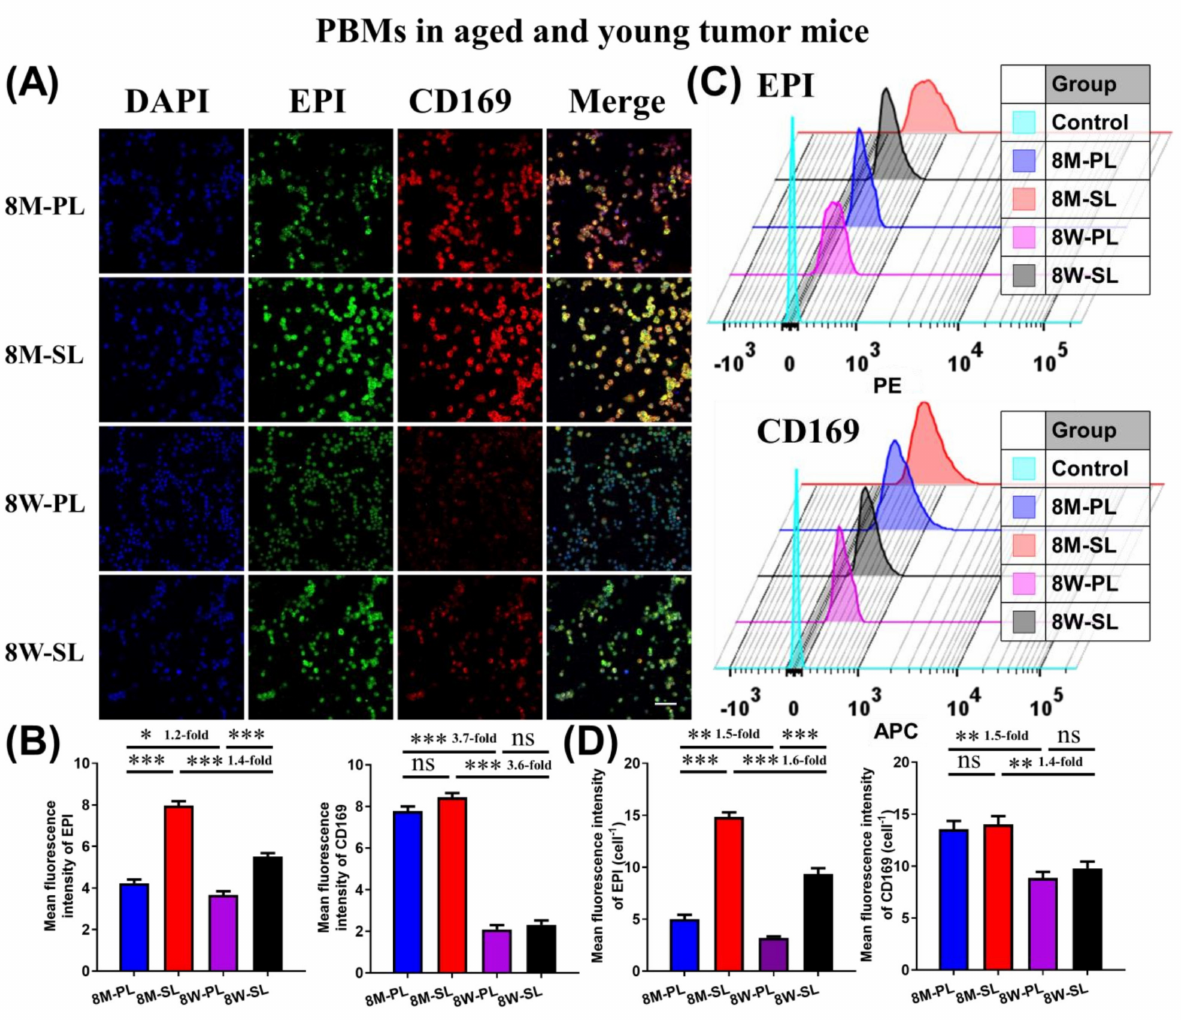
Figure 4. ( A ) When isolated Peripheral Blood Monocytes were incubated with EPI-SL and EPI-PL for 2 h, the fluorescence picture of isolated PBMs was taken by a confocal microscope (green fluorescence: EPI, red fluorescence: CD169. Scale bar = 100 µ m), ( B ) and the fluorescence intensity of EPI and CD169 in isolated PBMs was measured by ImageJ (1 dm × 1 dm, n = 3, ns p ≥ 0.05, * p < 0.05, ** p < 0.01, and *** p < 0.001). ( C ) When isolated PBMs were incubated with EPI-SL and